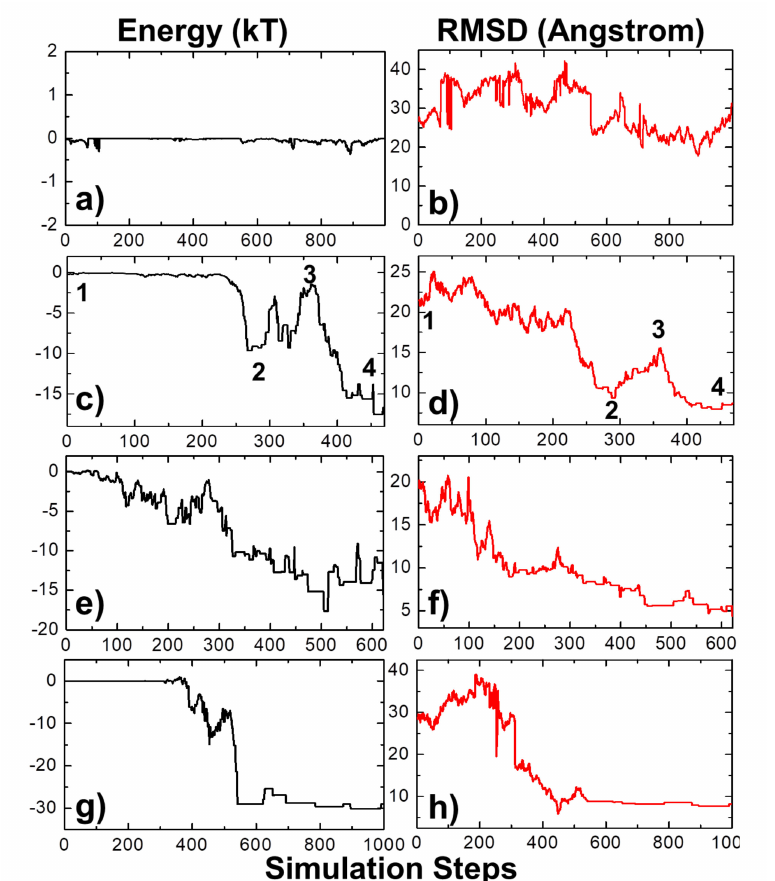
Figure 3. The protein complex 2VLN was selected from the benchmark as a specific example to characterize the dynamic mechanisms of association. Among its 10 4 simulation trajectories, we further picked four representatives to illustrate the detailed association processes. The changes in the total intermolecular interactions between two binding partners in these four trajectories are plotted by black curves on the left side in ( a ), ( c ), ( e ) and ( f ) as a function of simulation steps, while their changes in the root-mean-square di ff erence (RMSD) from the native complex are plotted on the right side by red curves in ( b ), ( d ), ( f ) and ( g ), respectively. Finally, four representative kinetic steps along the association pathways are marked by the numbers “1”, “2”, “3” and “4” in ( c ) and ( d